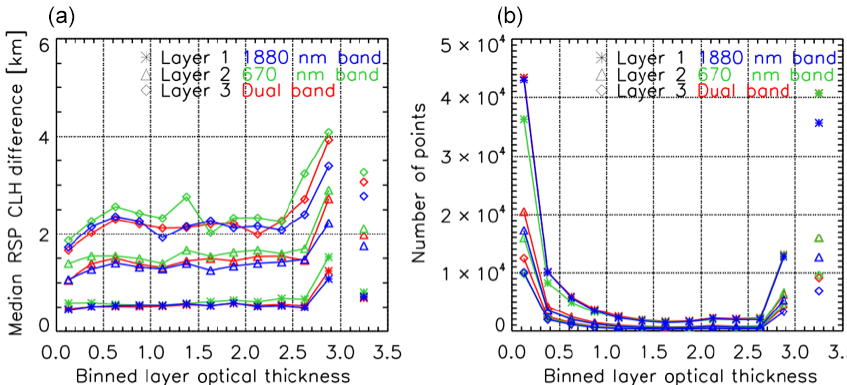
Figure 9. RSP CTH error (a) and number of samples (b) versus CPL cloud optical thickness for the 1880nm band (blue), 670nm band (green) and the dual band (red). The first, second and third layers are shown as stars, triangles and diamonds, respectively. Table 3. Summary of cloud top and cloud middle